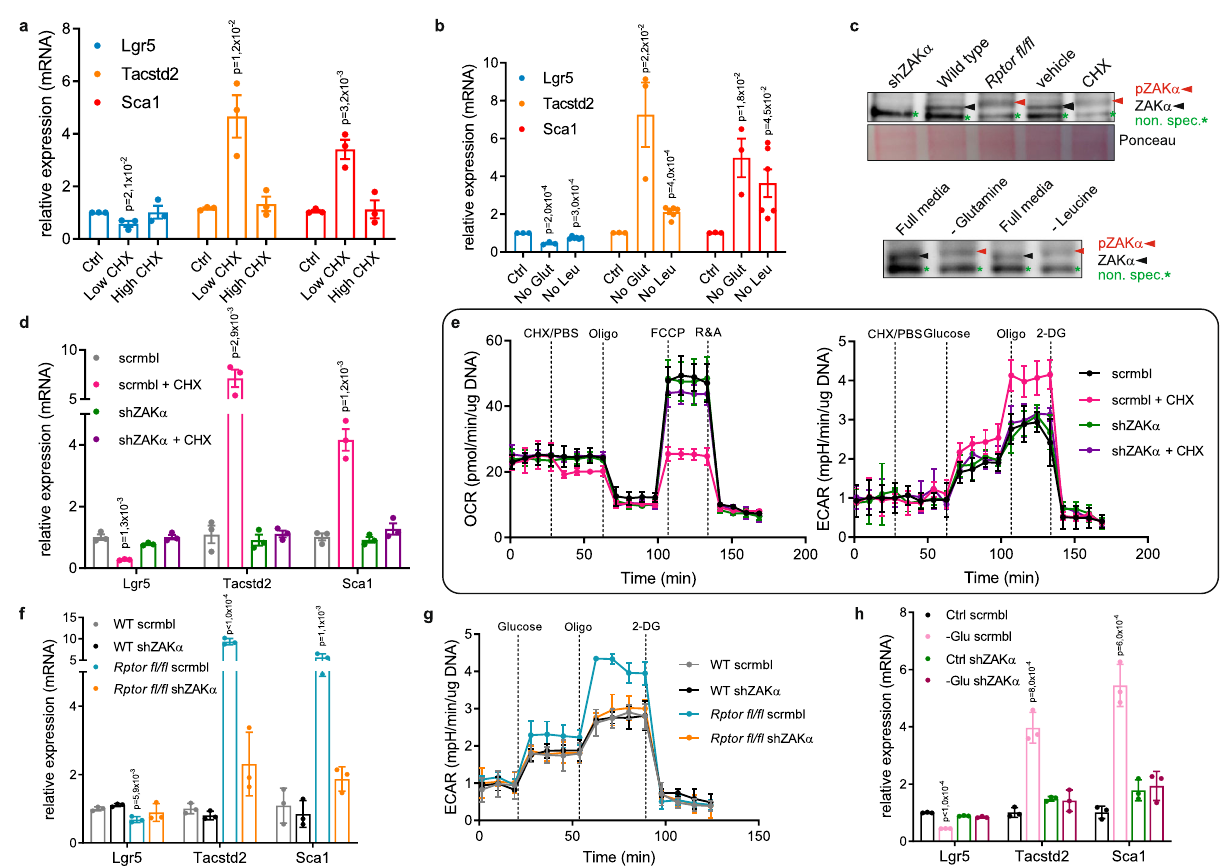
Fig.3|Ribosomeimpairmentdrivesmetabolicchangesandthefetalsignature via ZAK α activation. a RT-qPCR analysisof genes related to stem ( Lgr5 ) and fetal- likestate( Tacstd2 and Sca1 )ofWTorganoidstreatedwithcycloheximideateithera low (0.015ug/ml) or high dose (100ug/ml) for 30min. Hprt is used as a reference. Mean and SEM are shown ( n =3 biological replicates each accessed in technical triplicates). p -values were determined using a two-tailed t -test. b RT-qPCR analysis of genes related to stem ( Lgr5 ) and fetal-like state ( Tacstd2 and Sca1 ) of WT orga- noids cultured in media without glutamine or leucine for 1h. Hprt is used as a reference. Mean and SEM are shown ( n =3 biological replicates each accessed in technical triplicates). p -values weredetermined using a two-tailed t -test. c Western blot con fi rming activation of ZAK α in Rptor fl / fl and low-dose cycloheximide treated organoids (upper panel) and organoids deprived from glutamine and leucine (bottompanel)comparedtoWT.RedarrowsindicatephosphorylatedZAK α ,black arrows indicate the ZAK α levels, green stars indicate non-speci fi c bands. Ponceau servesasa loading control. Blots were done ontwoanimals. d RT-qPCRanalysis of genesrelatedtostem( Lgr5 )andfetal-likestate( Tacstd2 and Sca1 )ofWTorganoids treated with low-dose cycloheximide (0.015ug/ml) for 30min in the presence or